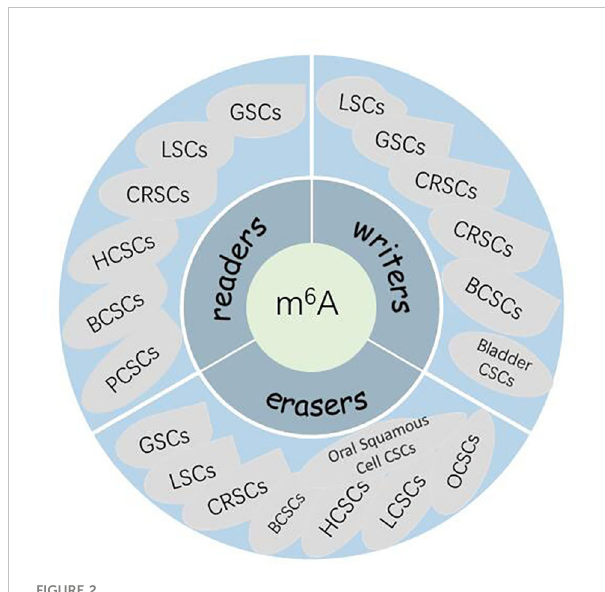
FIGURE 2 The role of m6A in maintaining